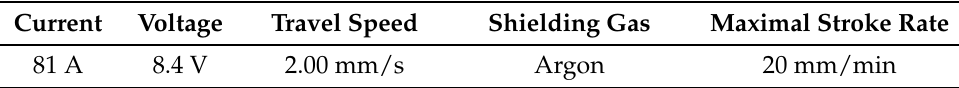
Table 1. PVR experiment parameter